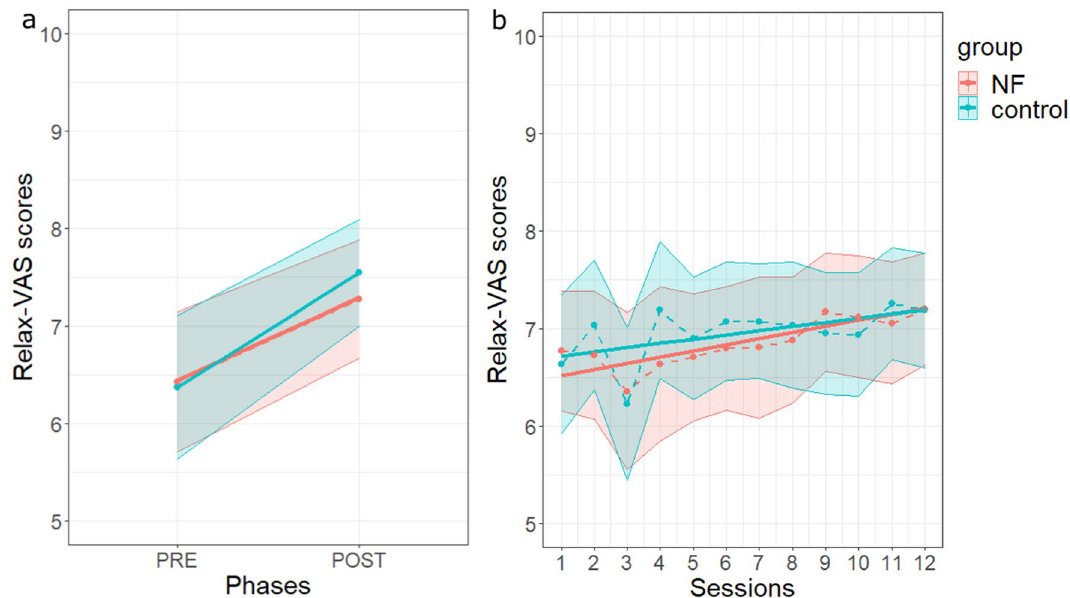
Figure 6. Effects of NFT on relax-VAS scores. ( a ) Pre-post (phase) mean effects. ( b ) Between-session effect on relax-VAS scores in each group. Same legend as in Fig. 5. Graphs were obtained with R software (v.4.0.2; R Core Team,